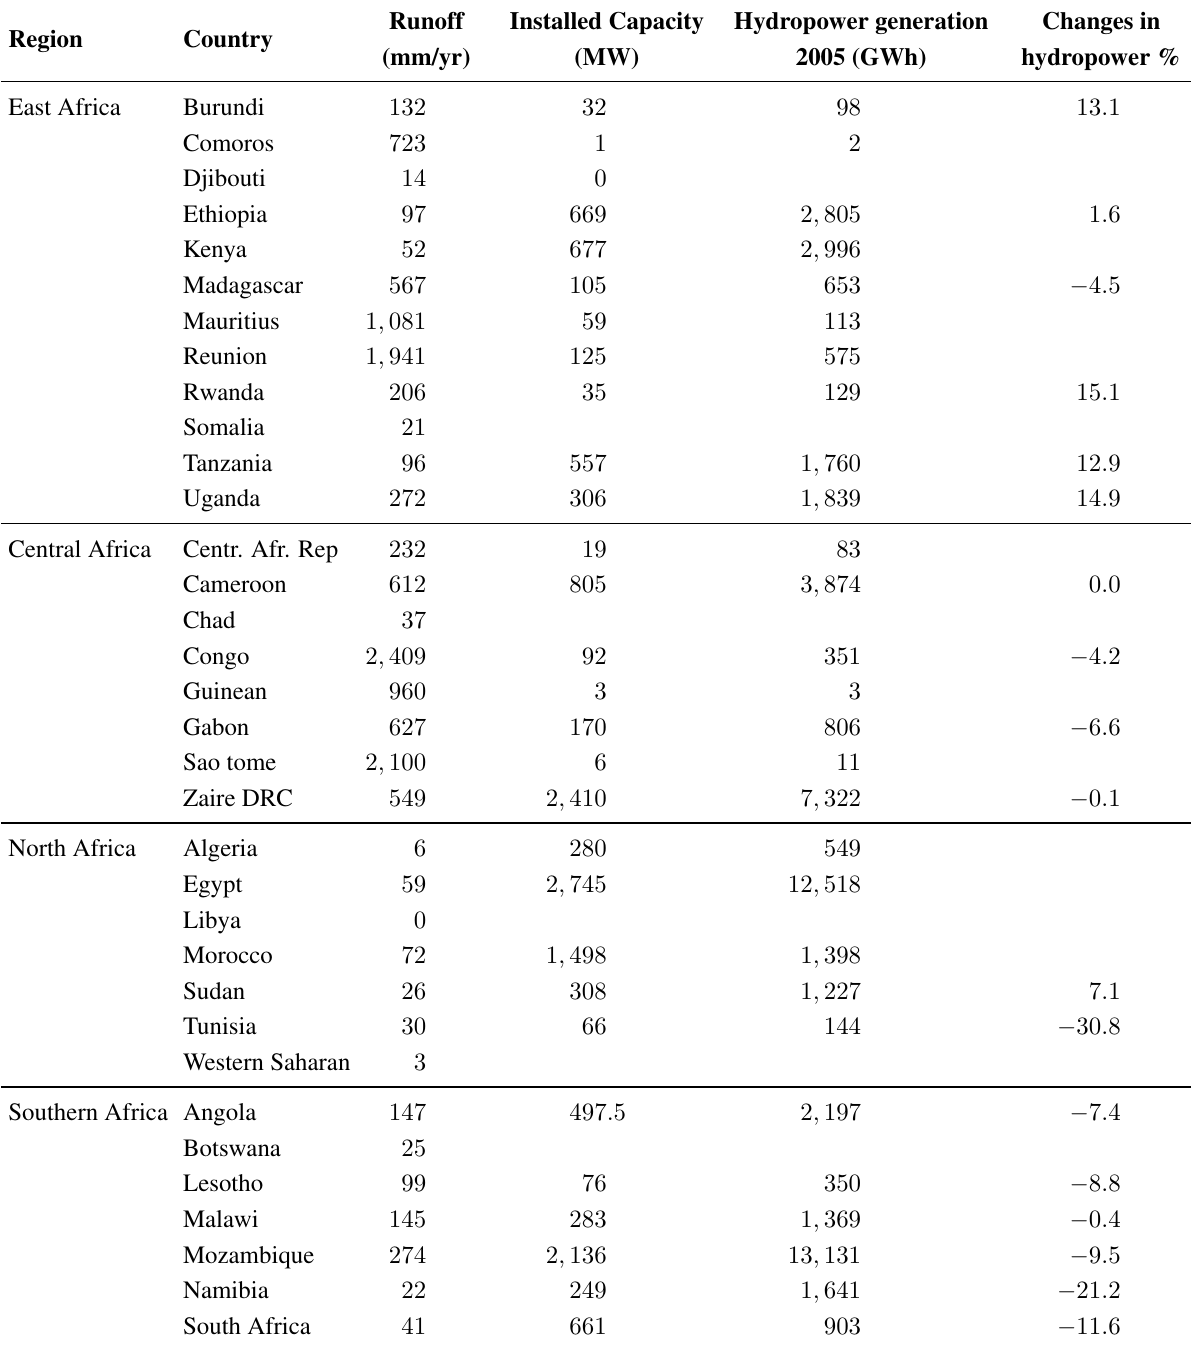
Table A1. African Regions and Countries in